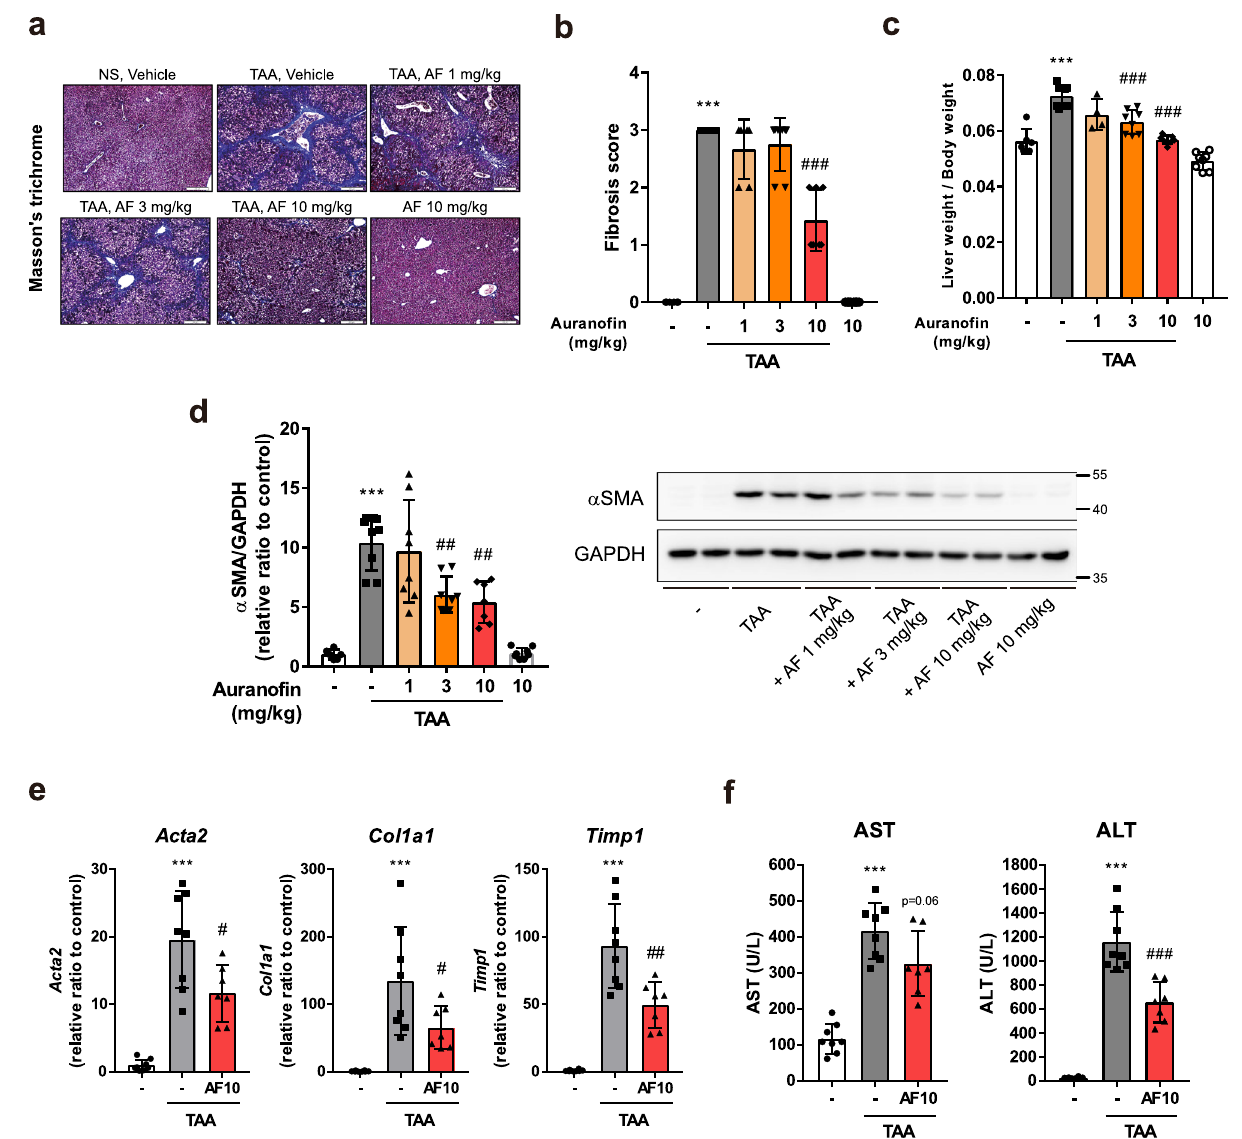
Fig. 1 Aurano fi n inhibits thioacetamide-induced liver fi brosis. a Representative Masson ’ s Trichrome stained liver sections demonstrating collagen deposition in thioacetamide (TAA) injected mice. NS; normal saline, AF; aurano fi n. b Fibrosis score assessed by liver pathologist in a blind manner. c Elevation of relative liver weight was decreased by the administration of aurano fi n. Data are presented as mean ± SD; n = 6 mice for control group, n = 7 mice for TAA + aurano fi n 10 mg/kg administered group and n = 8 mice for the rest of the groups. d Quanti fi cation of α SMA by western blot analysis and e Acta2 , Col1a1 , and Timp1 by qPCR. f Serum AST and ALT levels. Data are presented as mean ± SD; n = 8 mice for control group and TAA-administered group, n = 7 mice for TAA + aurano fi n 10 mg/kg administered group. *** p < 0.001, versus control group; # p < 0.05, ## p < 0.01, ### p < 0.001, versus TAA group by one-way ANOVA followed by Tuckey ’ s